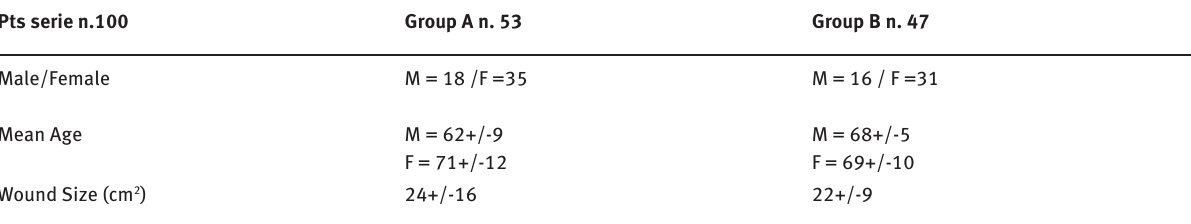
Table 1: Clinical features of Group A and Group B patients with mixed limb